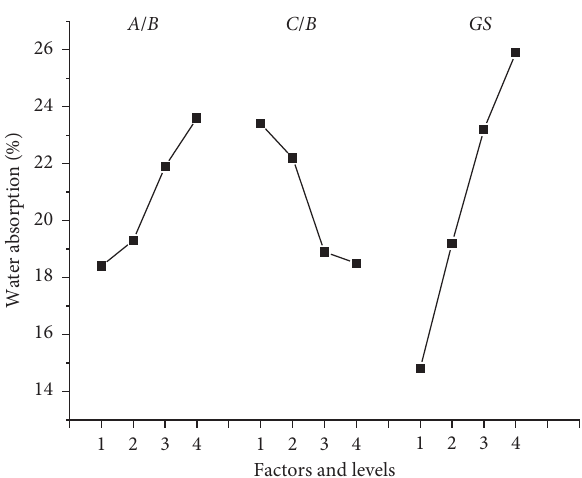
Figure 6: Sensitivity analysis of the permeability